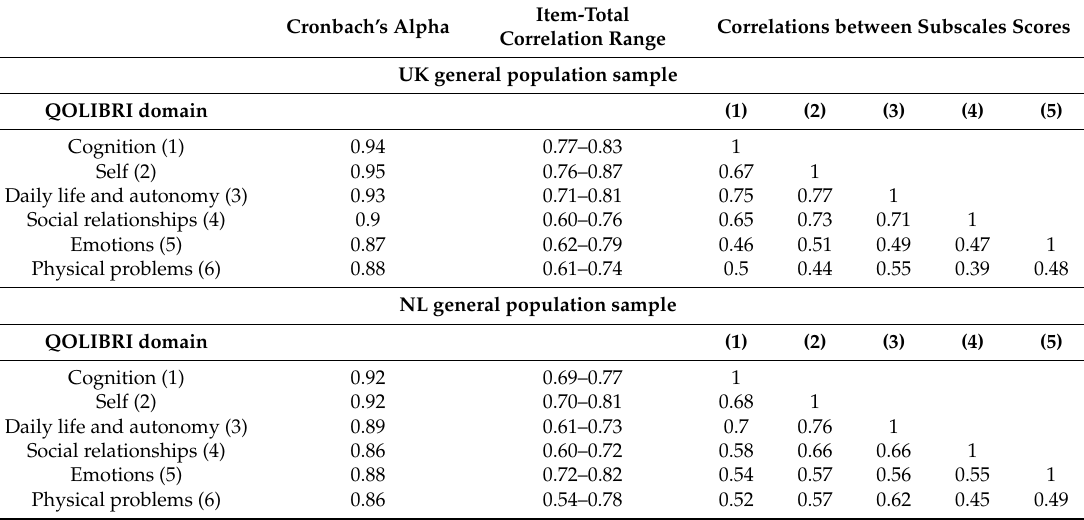
Table A2. Psychometric properties of the QOLIBRI